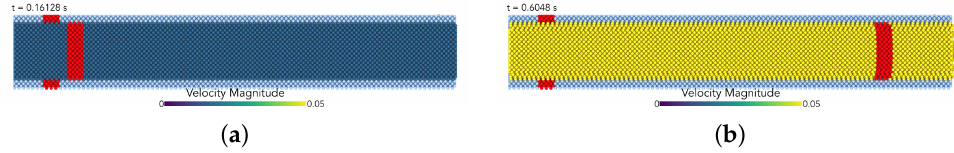
Figure 25. Bingham flow obtained with null elastic component. ( a ) Flow timelines at t = 0.16 s. ( b ) Flow timelines at t = 0.6 s. Flow obtained with: (cid:101) CS = 0, ρ = 1 × 10 3 , c = 1 × 10 − 1 , µ = 1 × 10 − 6 , g = 1 × 10 − 1